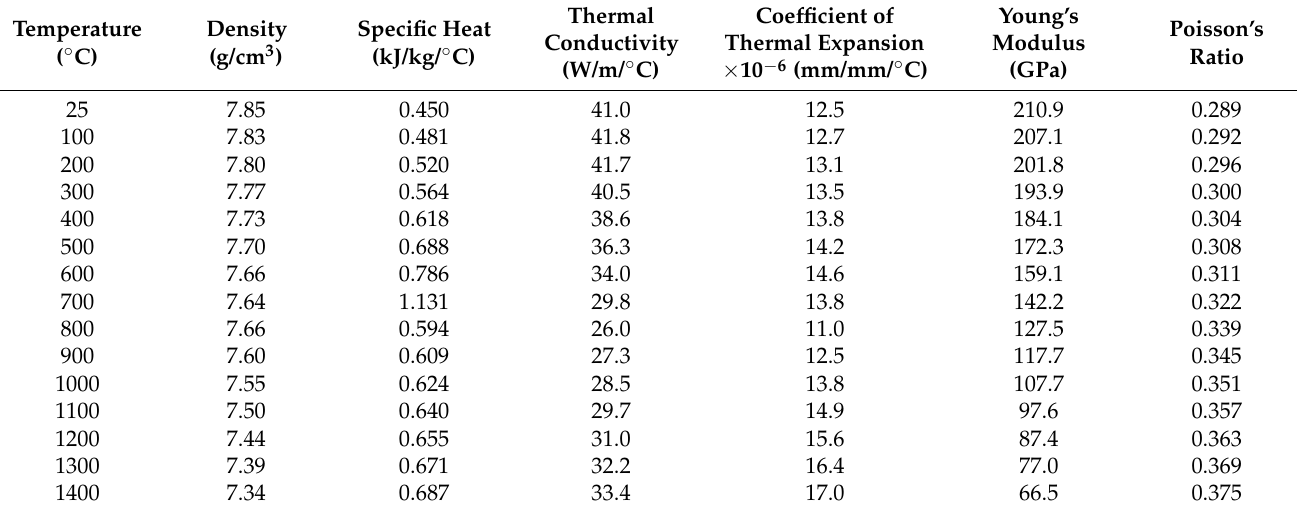
Table 8. Thermo-physical properties data of